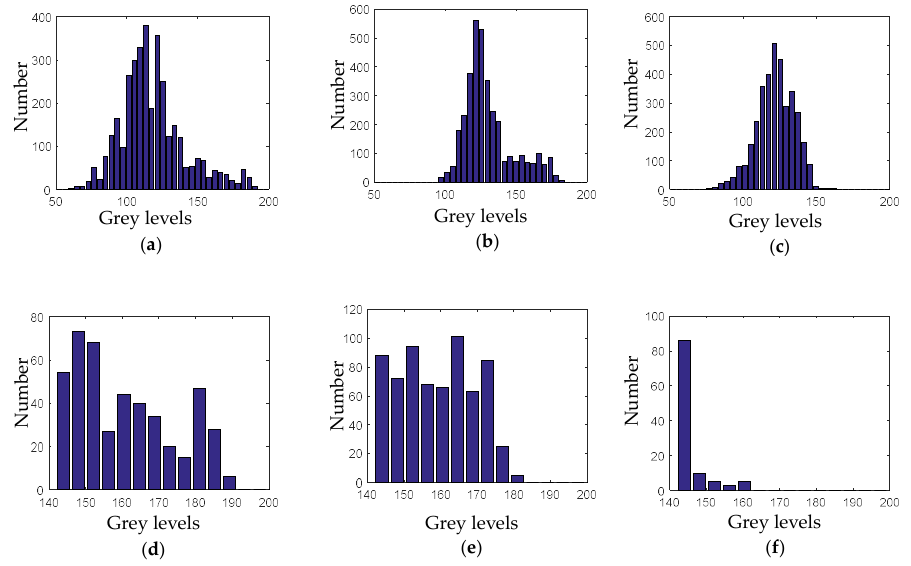
Figure 14. The grey histogram distribution characteristics of region 1, 2 and 3 at different frequency